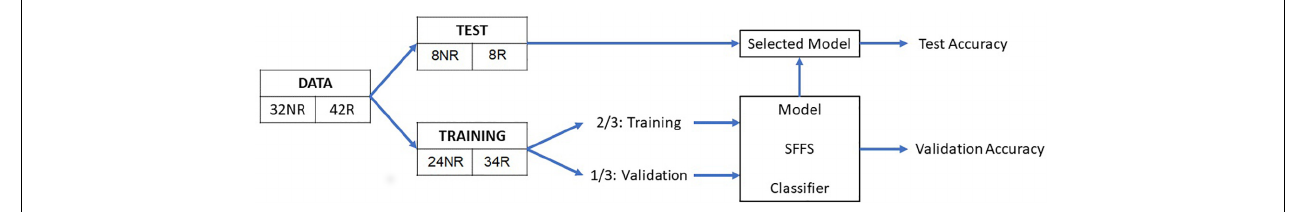
FIGURE 3 | Schematic representation of the overall method. NR, no recurrence; R, recurrence; SFFS, sequential forward floating search.